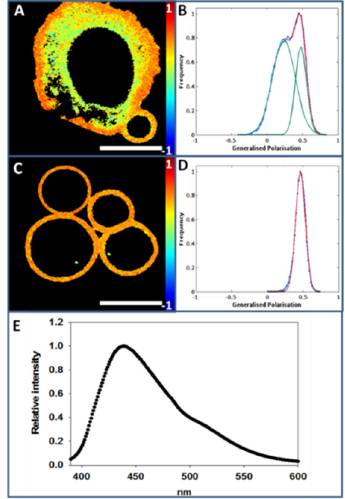
Figure 2. GPMV (bleb) formation and Laurdan GP measurements at 20 °C. ( A ), GPMV formation from a CHO cell (average GP value 0.44). ( B ), Generalized polarization plot of image A. ( C ), Laurdan staining of GPMV derived from CHO cells. ( D ), Generalized polarization plot of image C. ( E ), Laurdan emission spectrum of CHO cell blebs. Bar 10 µm.